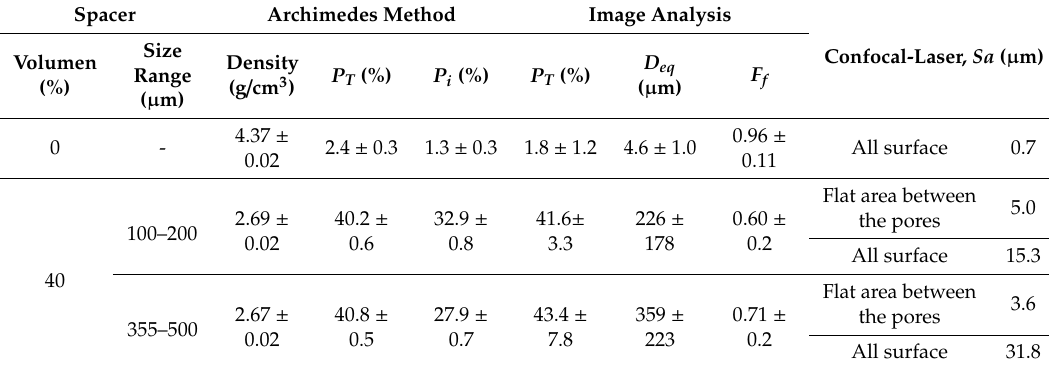
Figure 1. Image and roughness analysis of titanium substrates: fully-dense and with a 40 vol.% of spacer for two range size (100–200 µ m and 355–500 µ m). Figure ( A ), ( B ) and ( C ): Macrographs (high resolution camera), micrographs (Image Analysis) and SEM, respectively. Figure ( D ) and ( E ): porosity reconstruction performed by Sensomap 6.2 software (Leica, Glonn, Germany) (confocal-laser microscopy) and 3D topography of the surface of the samples. Table 1. Density, porosity and roughness evaluation obtained by Archimedes method, image analysis and confocal-laser microscopy, respectively.